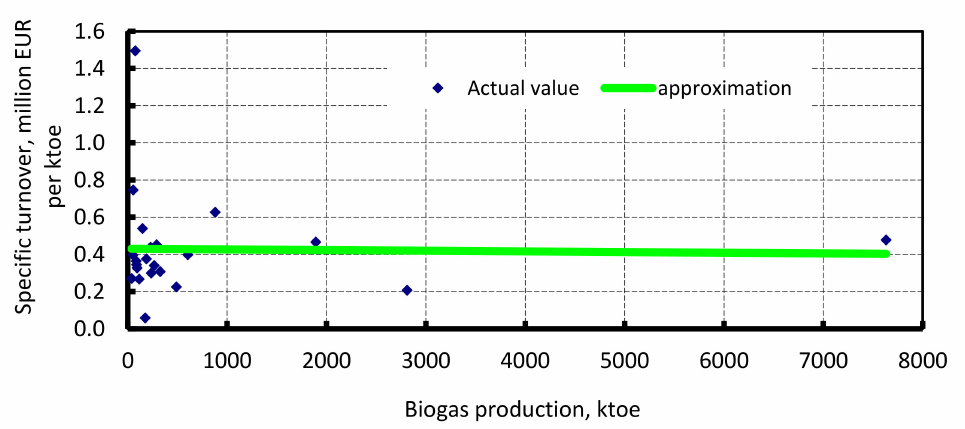
Figure 2. Specific turnover created by biogas